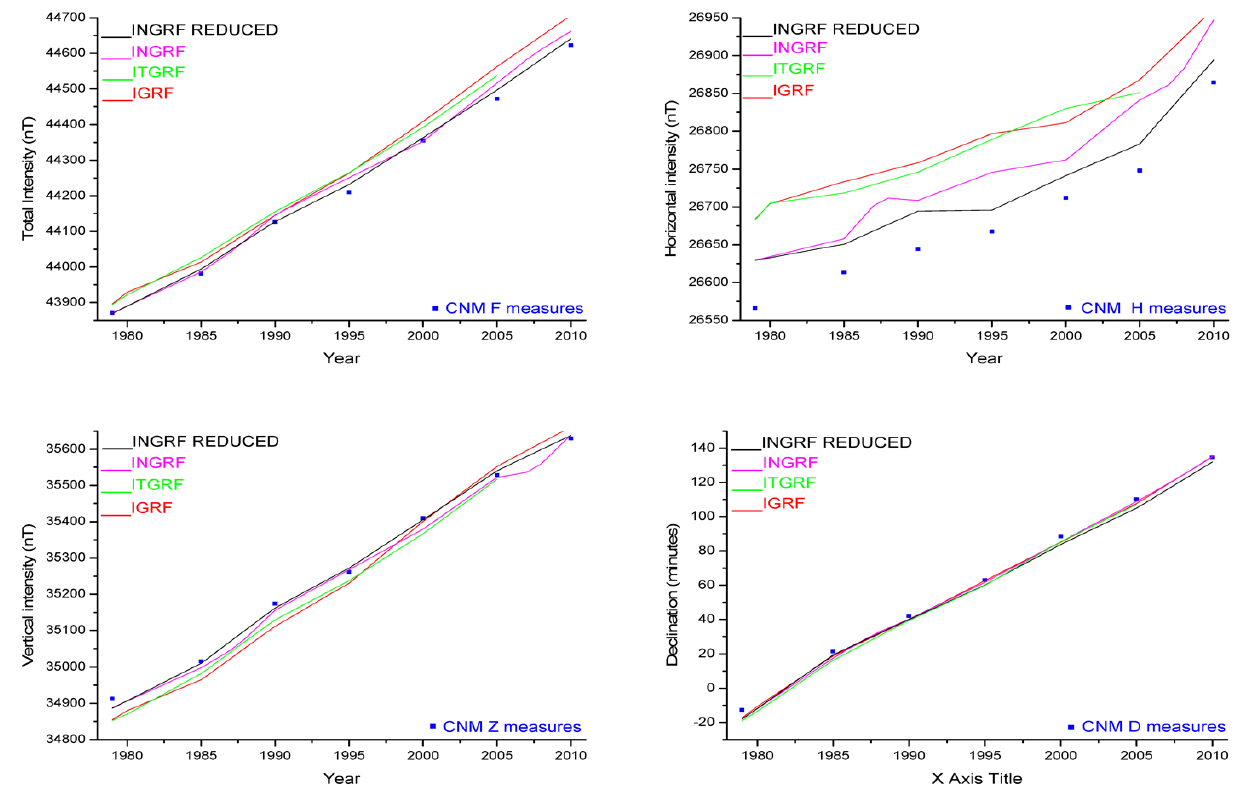
Figure 9. Measures of F, H, Z, D at CNM station (squares) together with the values predicted by various models (coloured lines).